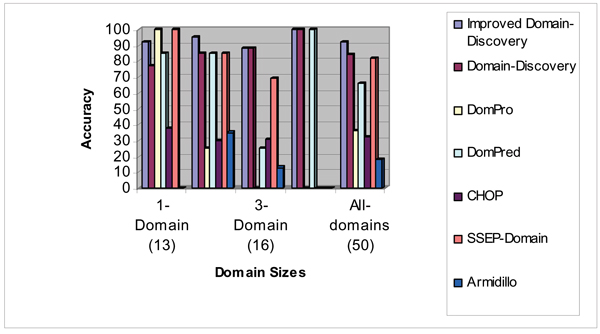
Percentage of Correct Prediction by different methods. Percentage of correct predictions for the number of domains defined for each method. If the boundary falls within 30% of the SCOP value the prediction is counted as correct.